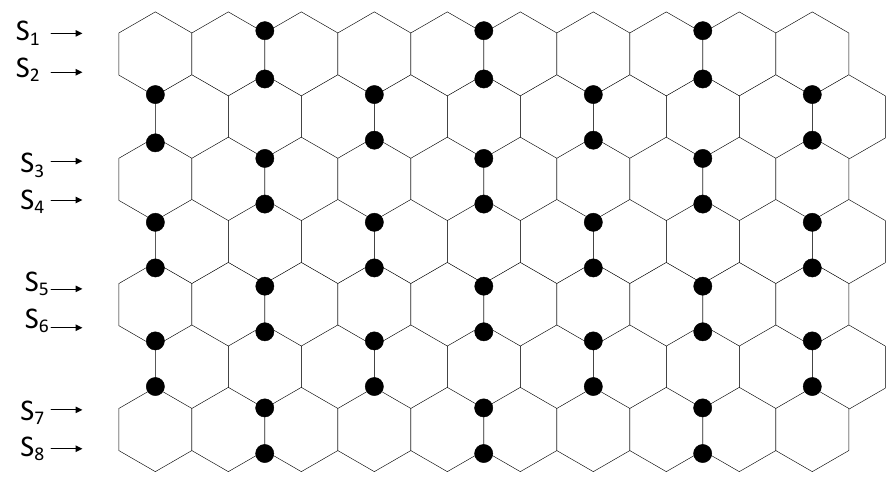
Figure 3. S 1 ∪ S 2 ∪ · · · ∪ S 8 on H 10,7